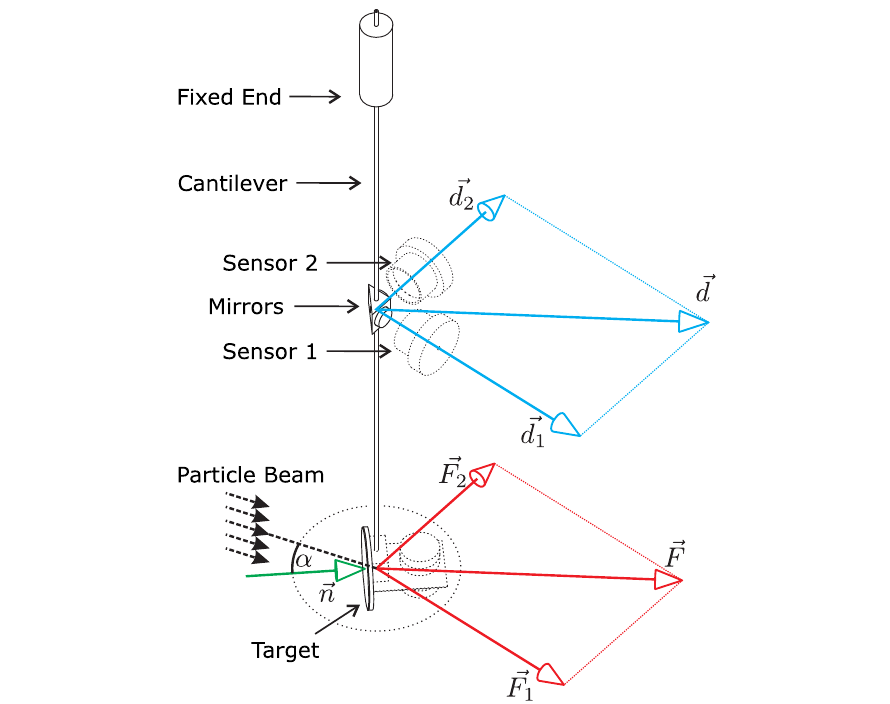
Fig. 2 The drawing of the essential parts shows that a force (cid:2) F acting at the target is related to a displacement (cid:2) d of the mirrors. The indexed components (cid:2) d (cid:2) d 1 and 2 of the displacement are measured through the two sensor optics and correspond to the two indexed force components (cid:2) F 1 and (cid:2) F 2 . The forces, the target normal (cid:2) n , and the incidence angle α of the beam belong to the same plane sketched by a dotted